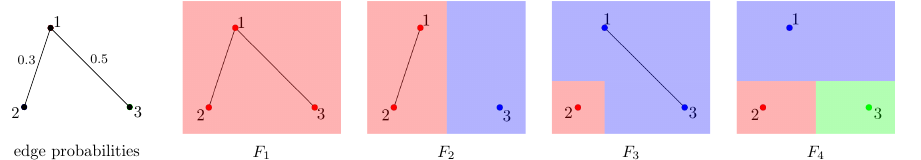
Figure 2. Edge probabilities of C and elements of F in example C given in (1) with clusters shown in different